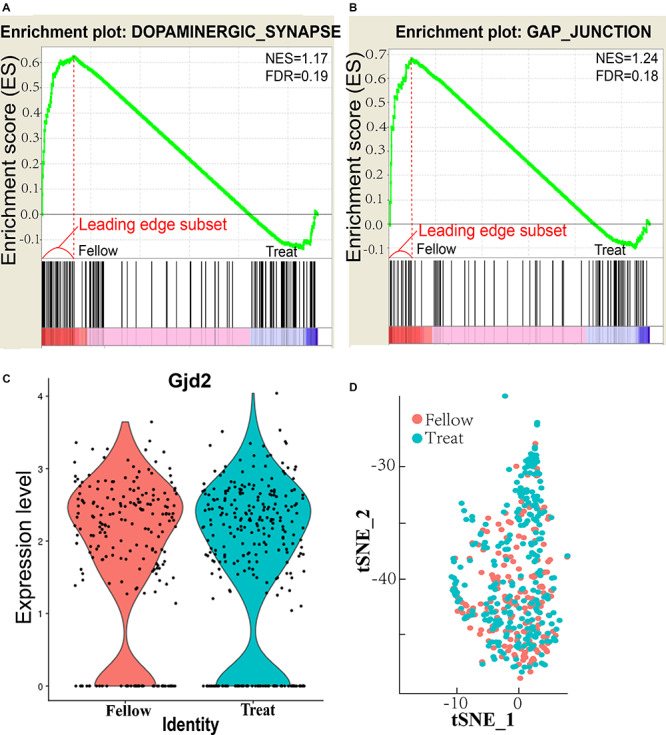
Enrichment pathways and plots of AII amacrine cells (ACs). (A) Enrichment plot of dopaminergic synapse. NES, normalized enrichment score; FDR, false discovery rate q value, <0.25 is statistically significant. (B) Enrichment plot of gap junction. (C) Retinal Gjd2 mRNA expression in treated eyes and fellow eyes after form deprivation for 2 days, no significant difference exists. (D) tSNE analysis of AII AC clusters in treated and follow eyes showed that there was no significant difference in cell numbers between treated and follow eyes.